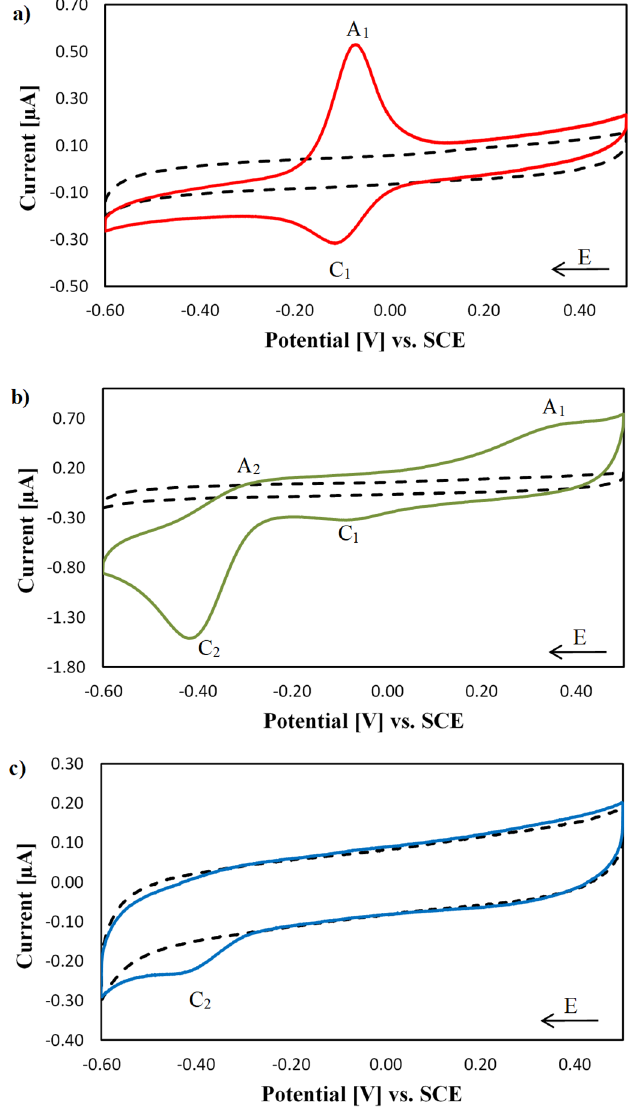
Figure 2. Typical cyclic voltammograms, scan rate 100 mV s − 1 , registered at the DNA biosensor in 0.1 M PB, pH 7.0 (black dashed trace), and in 20 µ M solutions of ( a ) [Cu(phen) 2 ] 2+ (red solid trace), ( b ) [Cu(TPMA)] 2+ (green solid trace) and ( c ) TPMA ligand (blue solid trace). Scan rates, 100 mV s − 1 . 2.3. Electrochemical Characterisation of [Cu(TPMA)(N,N ′ )] 2+ Complexes at the DNA Biosensor